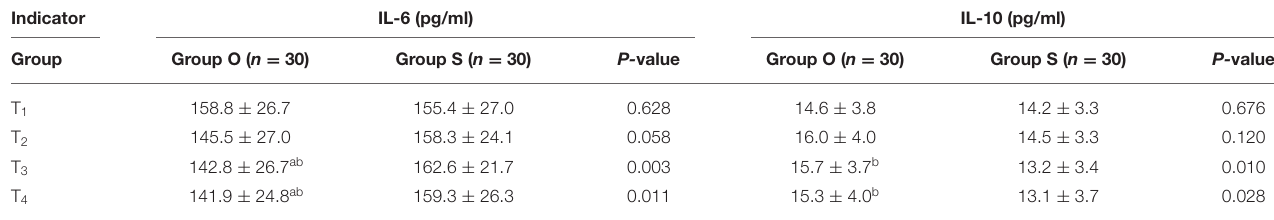
TABLE 2 | Comparison of serum IL-6 and IL-10 concentrations between the two groups. Indicator